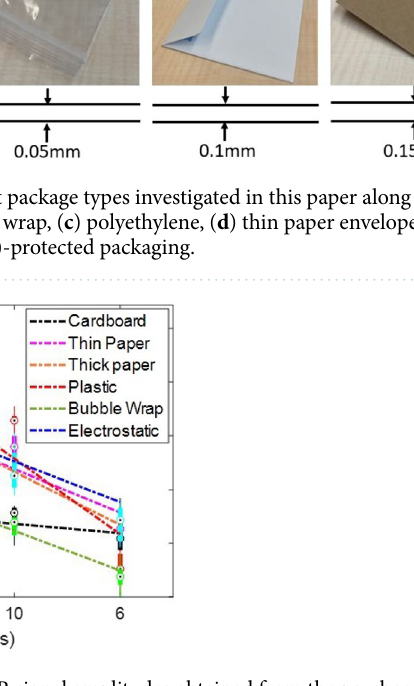
Figure 14. Comparison of 14 N NQR signal amplitudes obtained from the psychoactive drug benzocaine when the sample was enclosed within different types of packaging